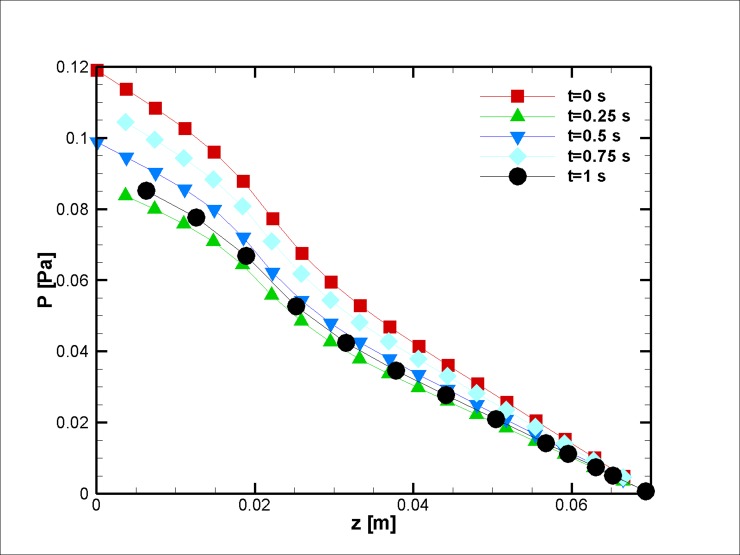
Pressure distribution along the mid-line of the stenosed (r = 2.5 mm) artery for the case without joule heating at five different time instances, Lvessel = 7 cm, Rvessel = 1 cm and fifty percent stenosis.